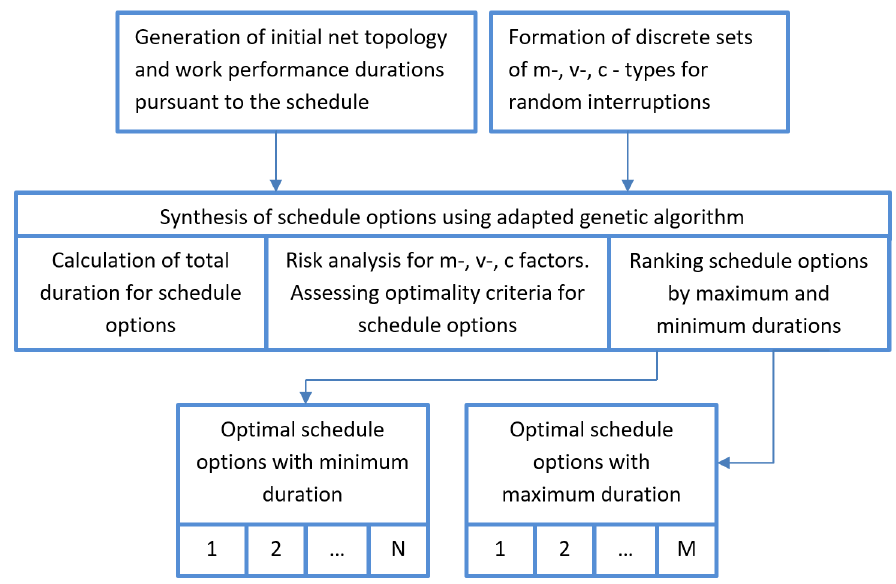
Figure 1. The block diagram describing the search for solutions applicable to a construction schedule with account taken of random factors.